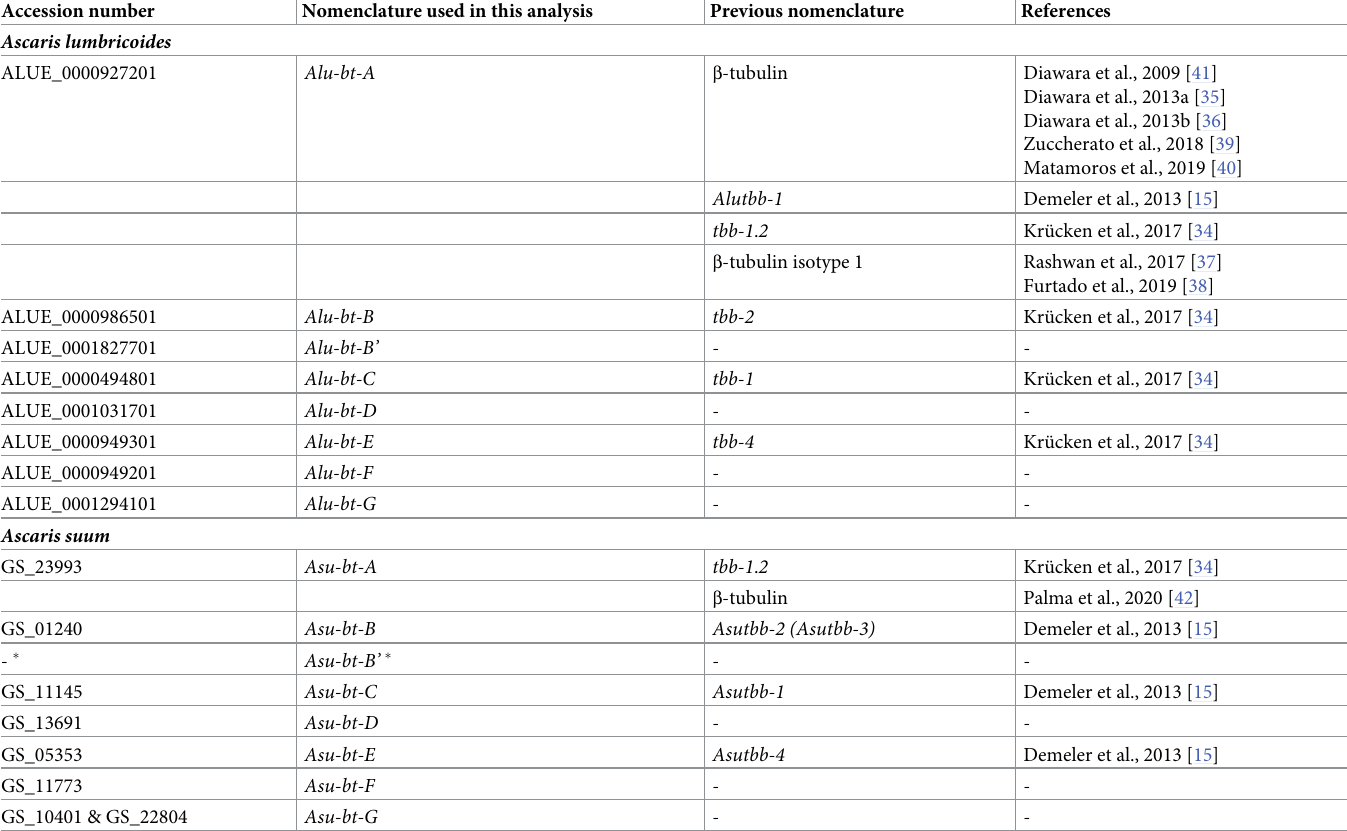
Table 2. Alignment of the proposed with the previously used nomenclature for β -tubulins of Ascaris